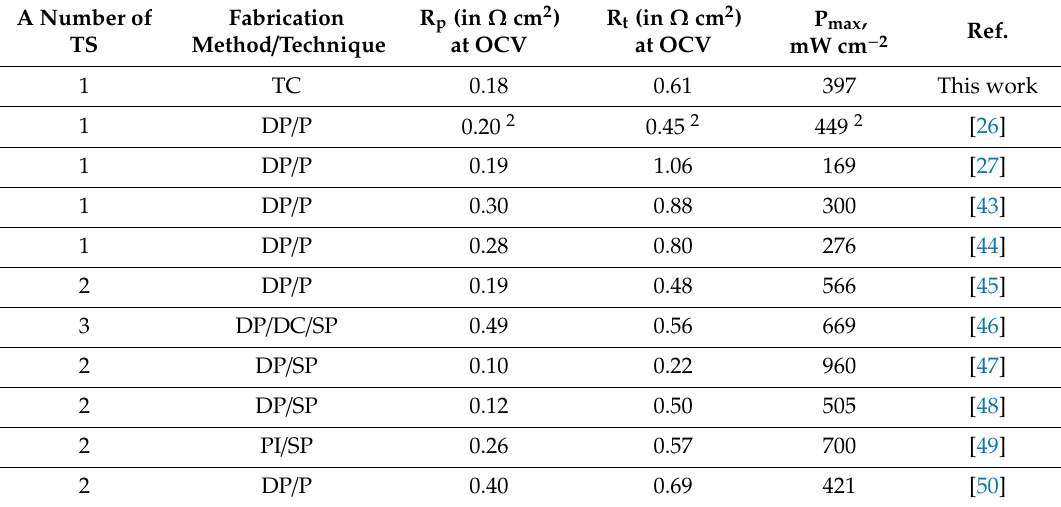
Table 1. Di ff erent PCFCs and their out-put performance at 600 ◦ C 1